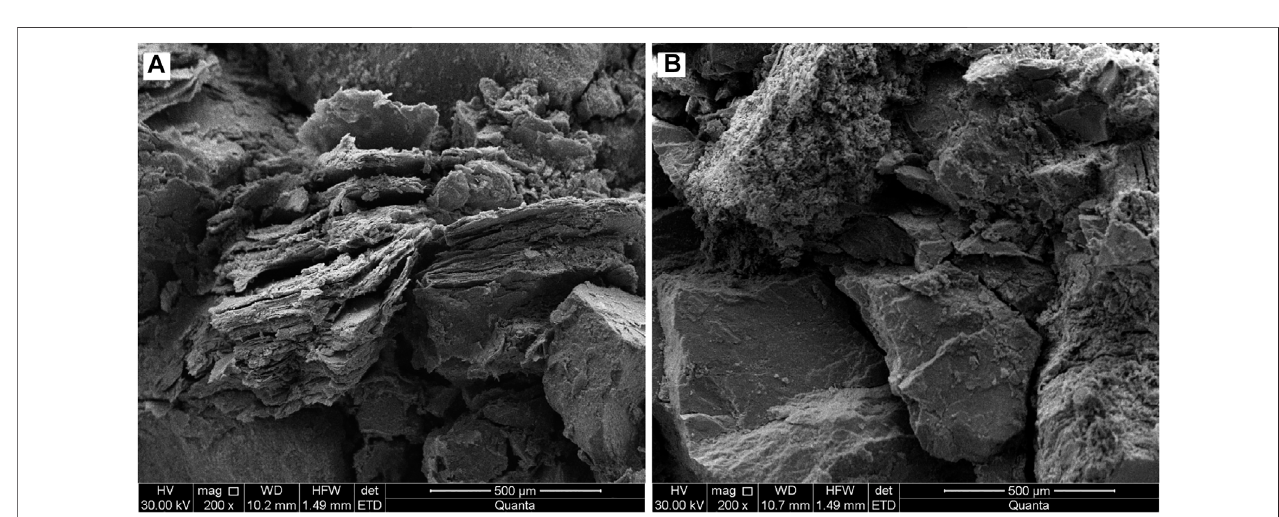
FIGURE13 | SEM micrographs of HWG Bin averticalplane ofspecimen under 200xmagni fi cation: (A) the natural state; (B) at an effectiveconsolidation pressure of 900 kPa.